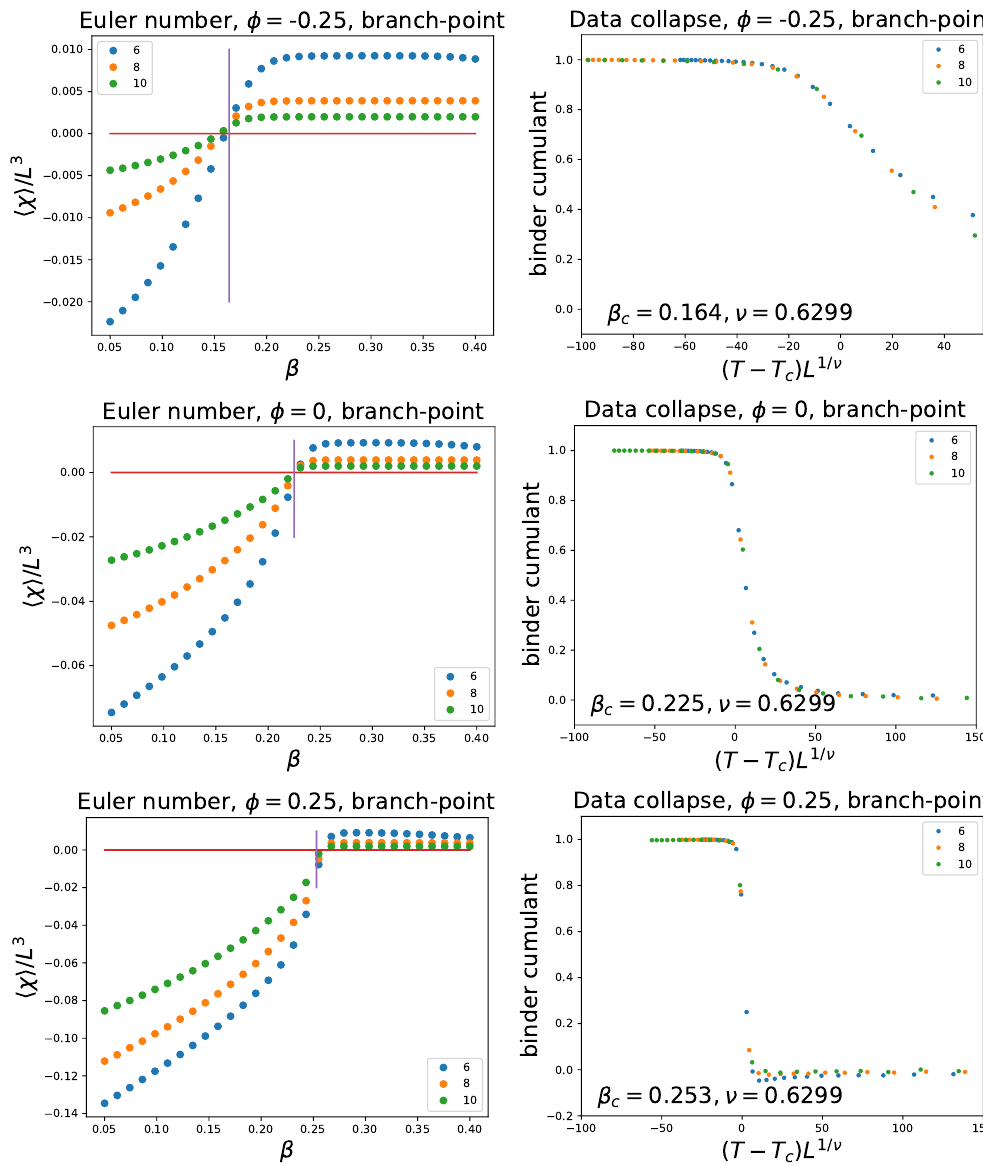
Figure 10: Scans varying β while holding φ fixed at various system sizes, using branch point vertex resolution protocol. Left column: Average euler character per domain wall component per unit volume, 〈 χ 〉 / L 3 . Right column: Binder cumulant ) L 1 ν . In the Euler number plots, we display a as a function of scaling variable ( β − β c vertical line at β = β (determined from the best collapse of the binder cumulant), c and a horizontal line at 〈 χ 〉 =